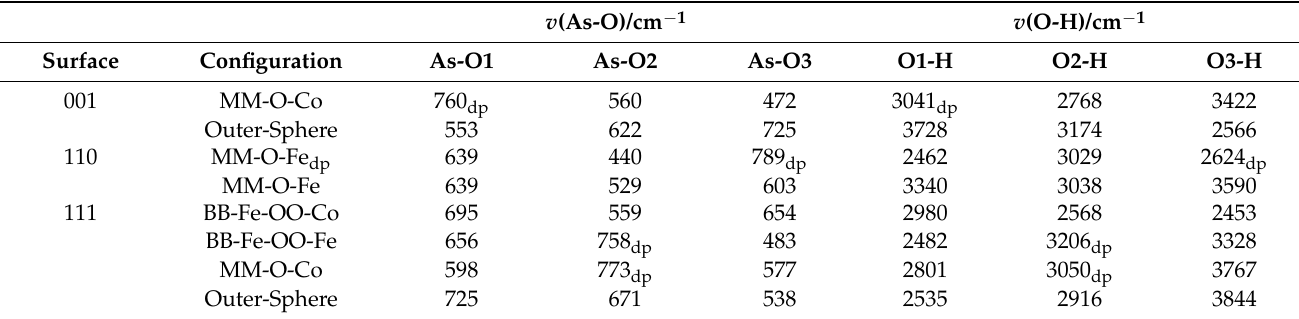
Table 4. Vibrational stretching frequencies of H 3 AsO 3 in isolation (with experimental values from the literature) and of all uniquely identified adsorption complexes on hydroxylated Fe 2 CoO 4 (001), (110), and (111) surfaces (dp =